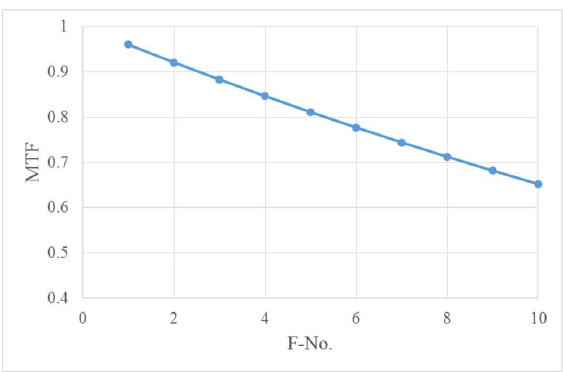
Figure 2. The relationship between MTF (modulation transfer function) limited by diffraction and F number.